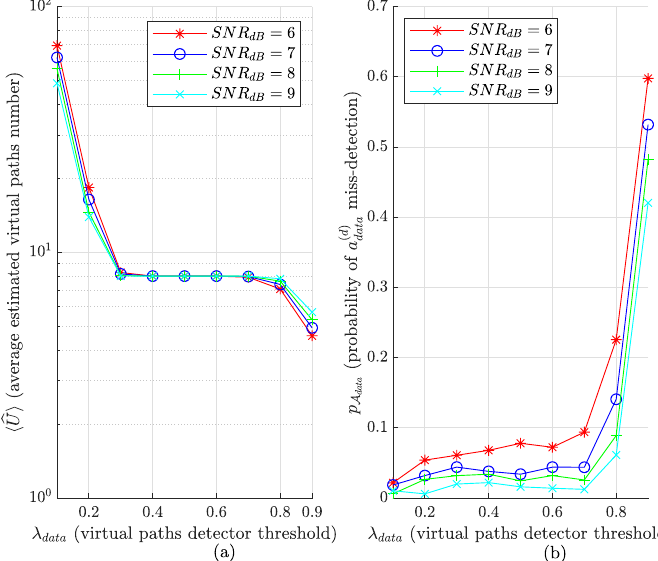
Figure 14. Eve blind payload demodulation performance as a function of λ data for several SNR values and SF = 7. ( a ): Average estimated virtual paths number. ( b ): Probability of a ( d )